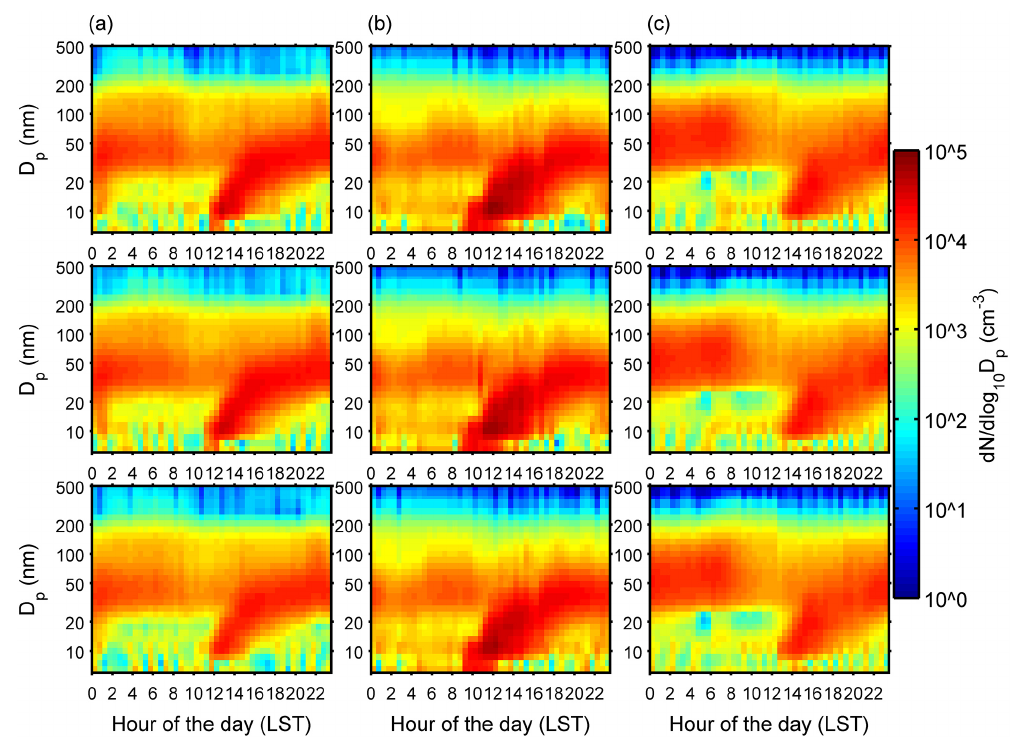
Figure 5. Measured particle size distributions (corrected for tubing losses) at the three sampling heights: the upper panels show measurements from 28m, the middle panels depict data from 20m, and the lower panels show data from 12m for (a) 29 March 2012, (b) 23 April 2012 and (c) 12 October 2012. The data are shown as the average of 10min of measurements at each height during each half-hour. Table 1. Correlation coefficients (Spearman ranked correlation ( ρ) and Pearson correlation ( r )) for GR (at 20m) in the 3h after the minimum geometric mean diameter (GMD) was observed and total modeled BVOC emissions for the 3h prior to the min(GMD) and 1 h subsequent to the min(GMD) for all events recorded during the active vegetation season (defined here as LAI >3). Note the correlation coefficients with GR from the other three measurement heights are indistinguishable from those reported for 20m in the table. Note the instrument was not operated at the site during April–July 2013, inclusive leading to the lower number of observed NPF events during the 2013 vegetation